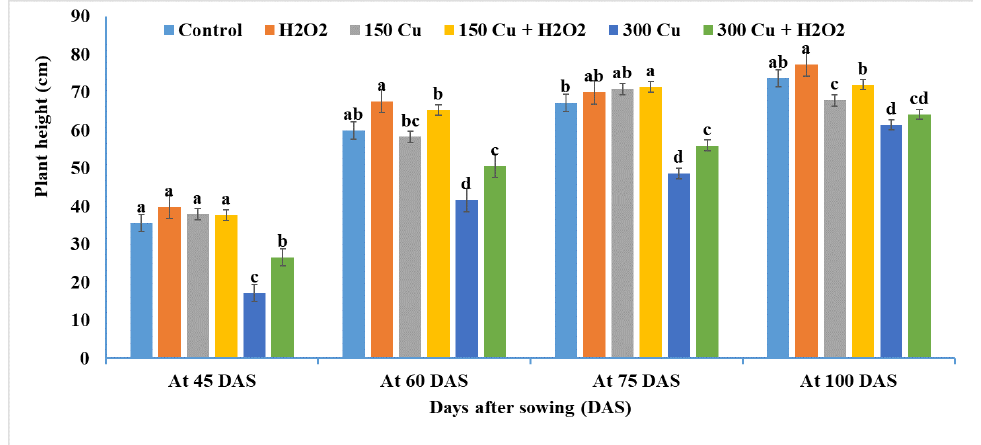
Figure 1. Effect of hydrogen peroxide on plant height at 45, 60, 75, and 100 days after sowing (DAS) of wheat grown in copper contaminated sandy soil. Means followed by the same letter at each sampling date are not significantly different according to the least significant differences (LSD) test ( p ≤ 0.05). Error bars are ± Standard Error (SE).